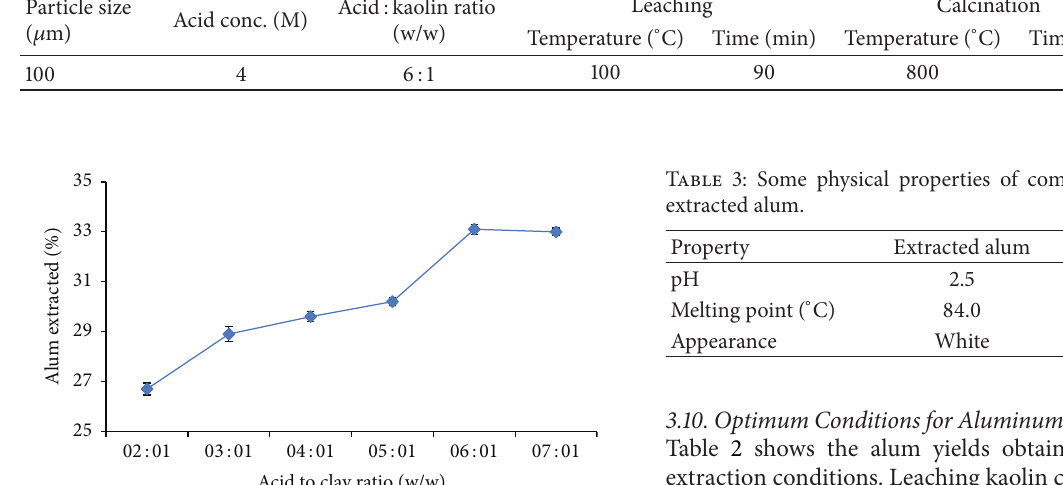
Figure 8: Effect of acid volume on the extraction of aluminum sul- phate (leaching time: 1.5h; particle size: 100 𝜇 m; acid concentration: 4 M; leaching temperature: 100 ∘ C; error bar = ± SD; and 𝑛 = 3 ).